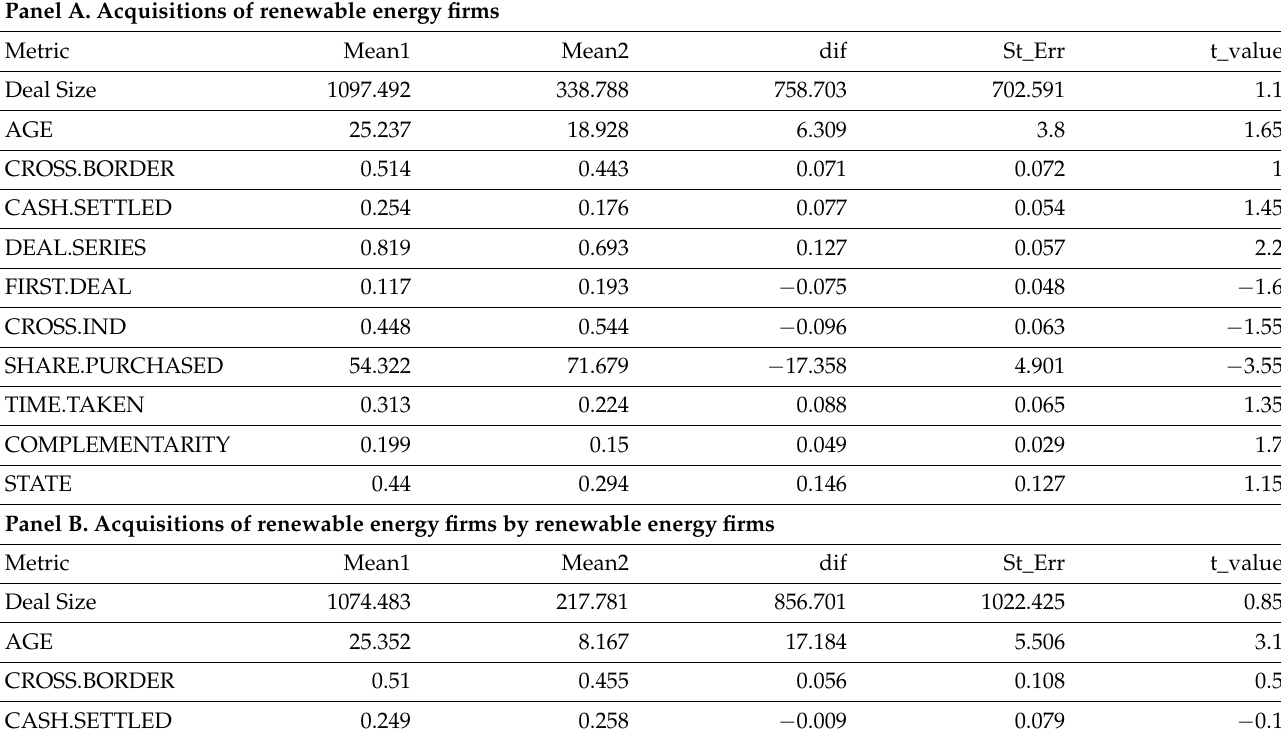
Table 3. Acquirer characteristics and deal details: cross-sectional comparison depending on the target type. Panel A. Acquisitions of renewable energy